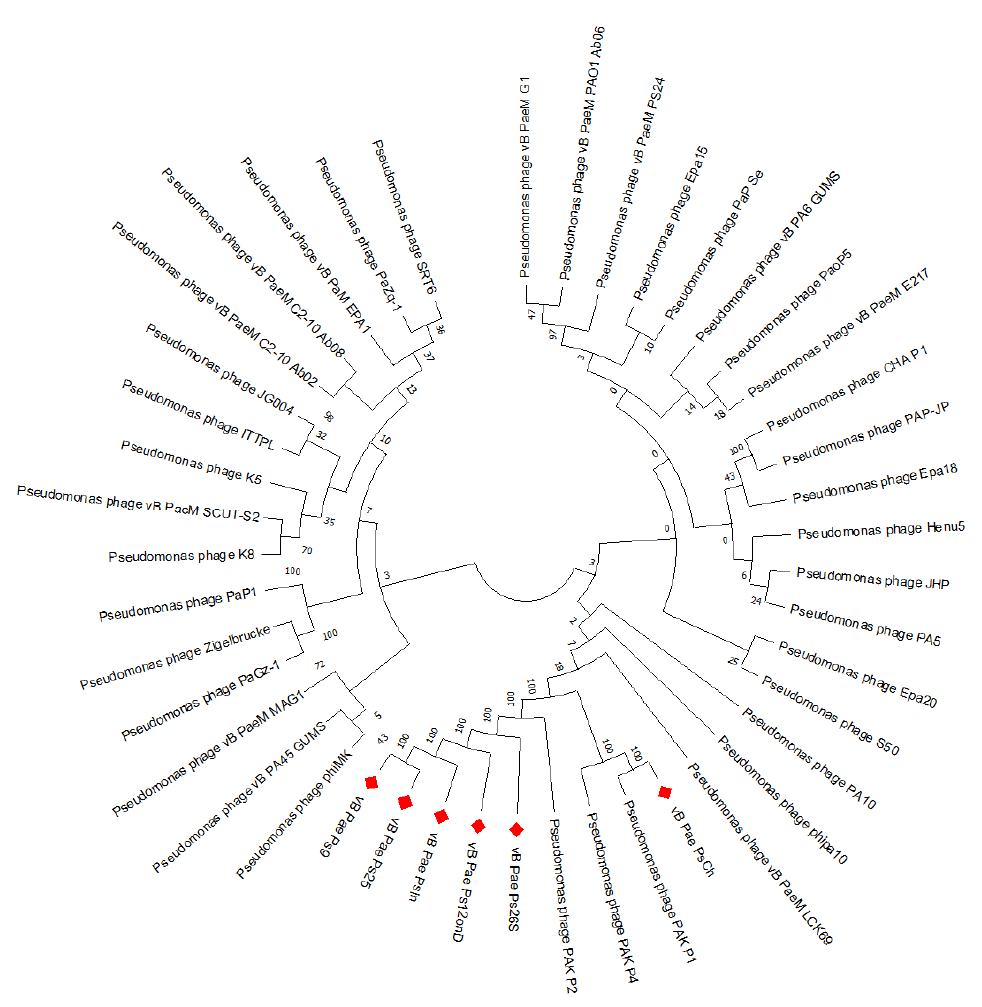
Figure 1. Phylogenetic tree based on whole-genome sequence comparisons of six selected phages, generated with MEGA X, version 10.2.4’s neighbor-joining method. The evolutionary distances were calculated using MEGA X’s Maximum Composite Likelihood method [51]. The percentage of replicate trees where the associated taxa clustered together during the bootstrap test is represented by the numbers below the branches (1000 replicates). The best tree is depicted to scale, with branch lengths representing the evolutionary distances used to infer the tree. In the final dataset, 45,933 positions were available for evolutionary analyses. Phages PsIn, PsCh, Ps25, Ps12on-D, Ps9, and Ps26S are indicated in red. Phages Ps9 and Ps26S are similar to phages Ps25 and Ps12on-D,